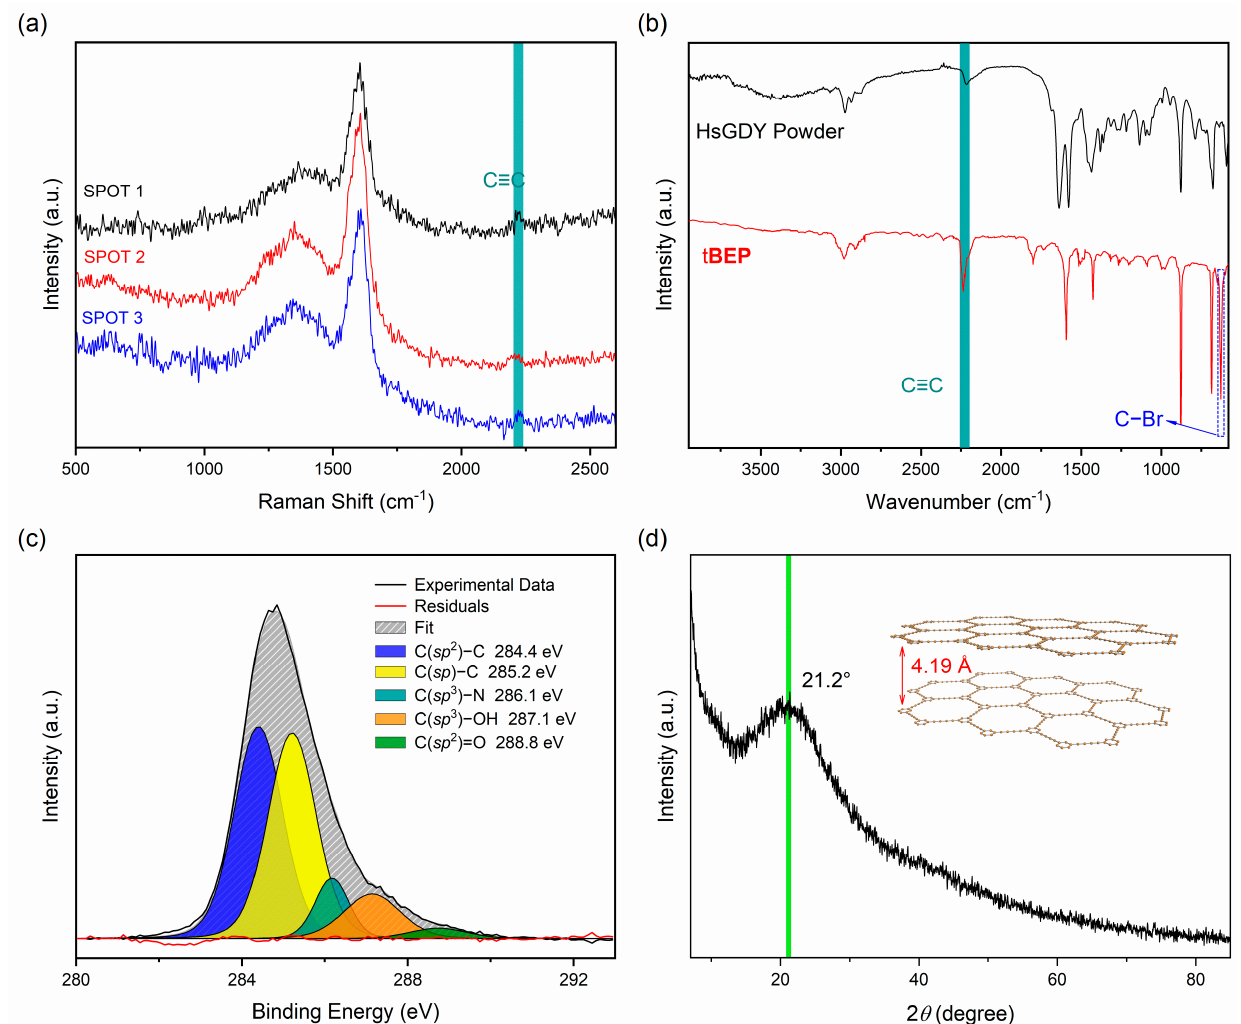
Figure 3. The structure of the HsGDY powder. ( a ) Raman spectra of random spots on the surface. ( b ) FT-IR spectra of the powder and tBEP. ( c ) XPS high-resolution C 1s spectrum of the powder. ( d ) XRD patterns of the powder.